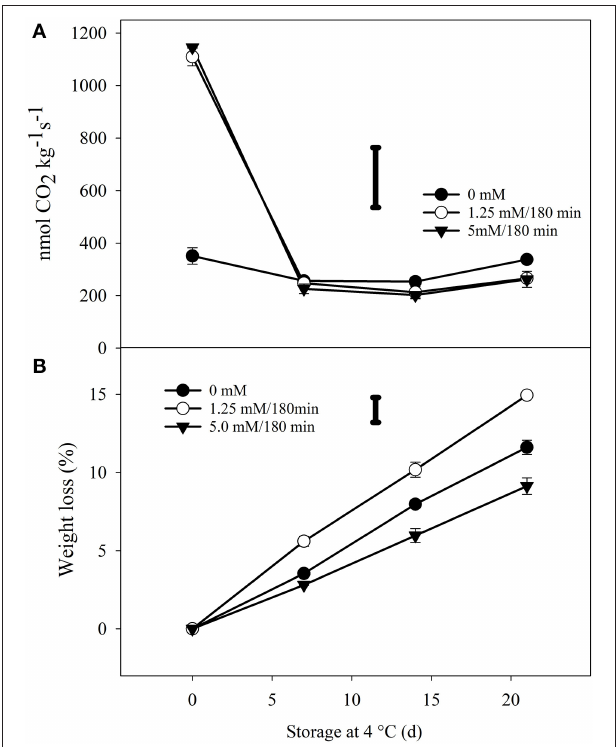
FIGURE 3 | Progress of respiration rate and weight loss of H 2 O 2 treated broccoli florets during storage of 21 d in the dark at 4 ◦ C/90–95% RH. (A) The average production of carbon dioxide (CO 2 ) of florets treated with three H 2 O 2 doses: (•) untreated (0mM); ( ) hormetic dose (1.25 mM/180min); and ( H ) ◦ high (5 mM/180min) dose. Each point is the mean of 4 replicates per treatment ( n 4) and vertical bars represents standard deviation. (B) Weight = loss (%) of florets during storage. Bars are the means of 9 replicates per treatment ( n 9) with SD. The bars in each graph represents the LSD value = ± (0.05) 228 (A) and 1.59 (B) . Sampling on day 0 was performed 6h after the = end of the treatments.